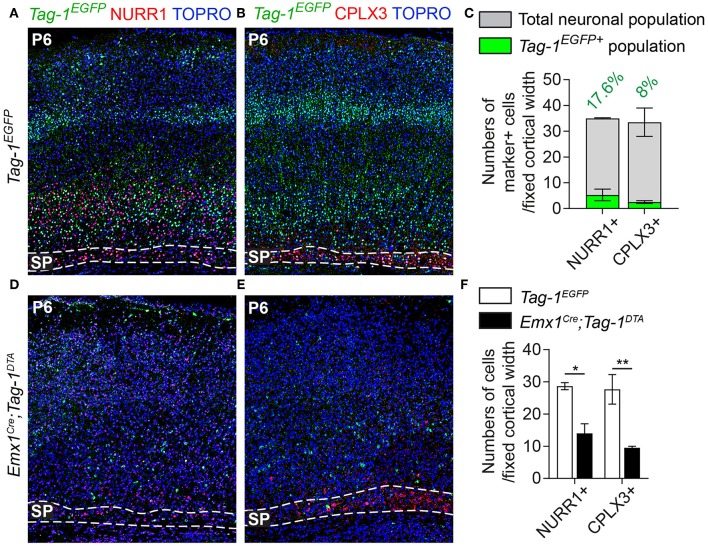
Targeted ablation of TAG-1+ cortical neurons results in reduced cells of the postnatal subplate. (A,B,D,E) Immunofluorescent analysis of Tag-1EGFP, NURR1, and CPLX3 at P6 in Tag-1EGFP and Emx1Cre;Tag-1DTA mice shows a detectable subplate at the somatosensory cortex. (C) Quantification of the contribution of Tag-1EGFP+ cells in the control subplate of the somatosensory cortex at P6. Data are plotted as mean ± SEM, N = 2. (F) Quantification of the cells of subplate in Tag-1EGFP and Emx1Cre;Tag-1DTA mice at P6 using the markers NURR1 and CPLX3. Data are plotted as mean ± SEM, N = 2. For NURR1+ cells, P = 0.019 and for CPLX3+ cells, P = 0.007. *p < 0.05, **p < 0.01.